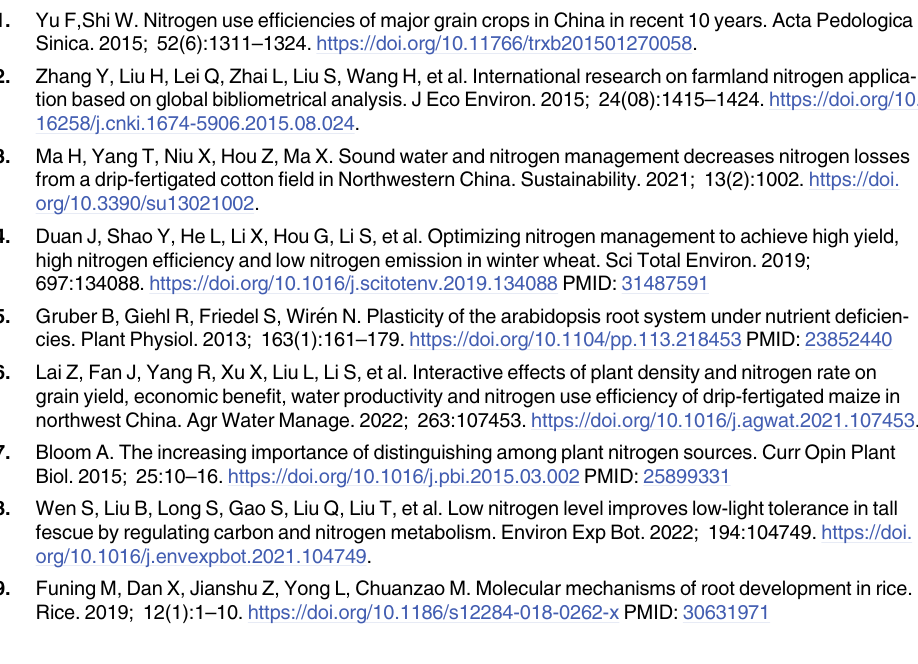
S1 Table. The data of this